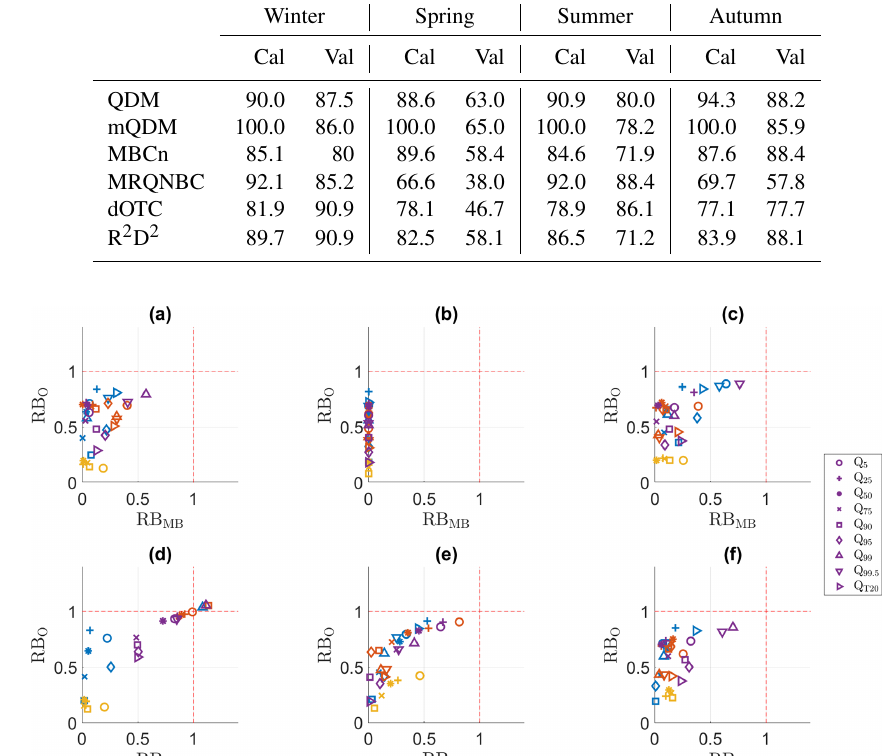
Table 8. PSS values for discharge in the calibration (Cal) and validation (Val) periods (%). Winter Spring Summer